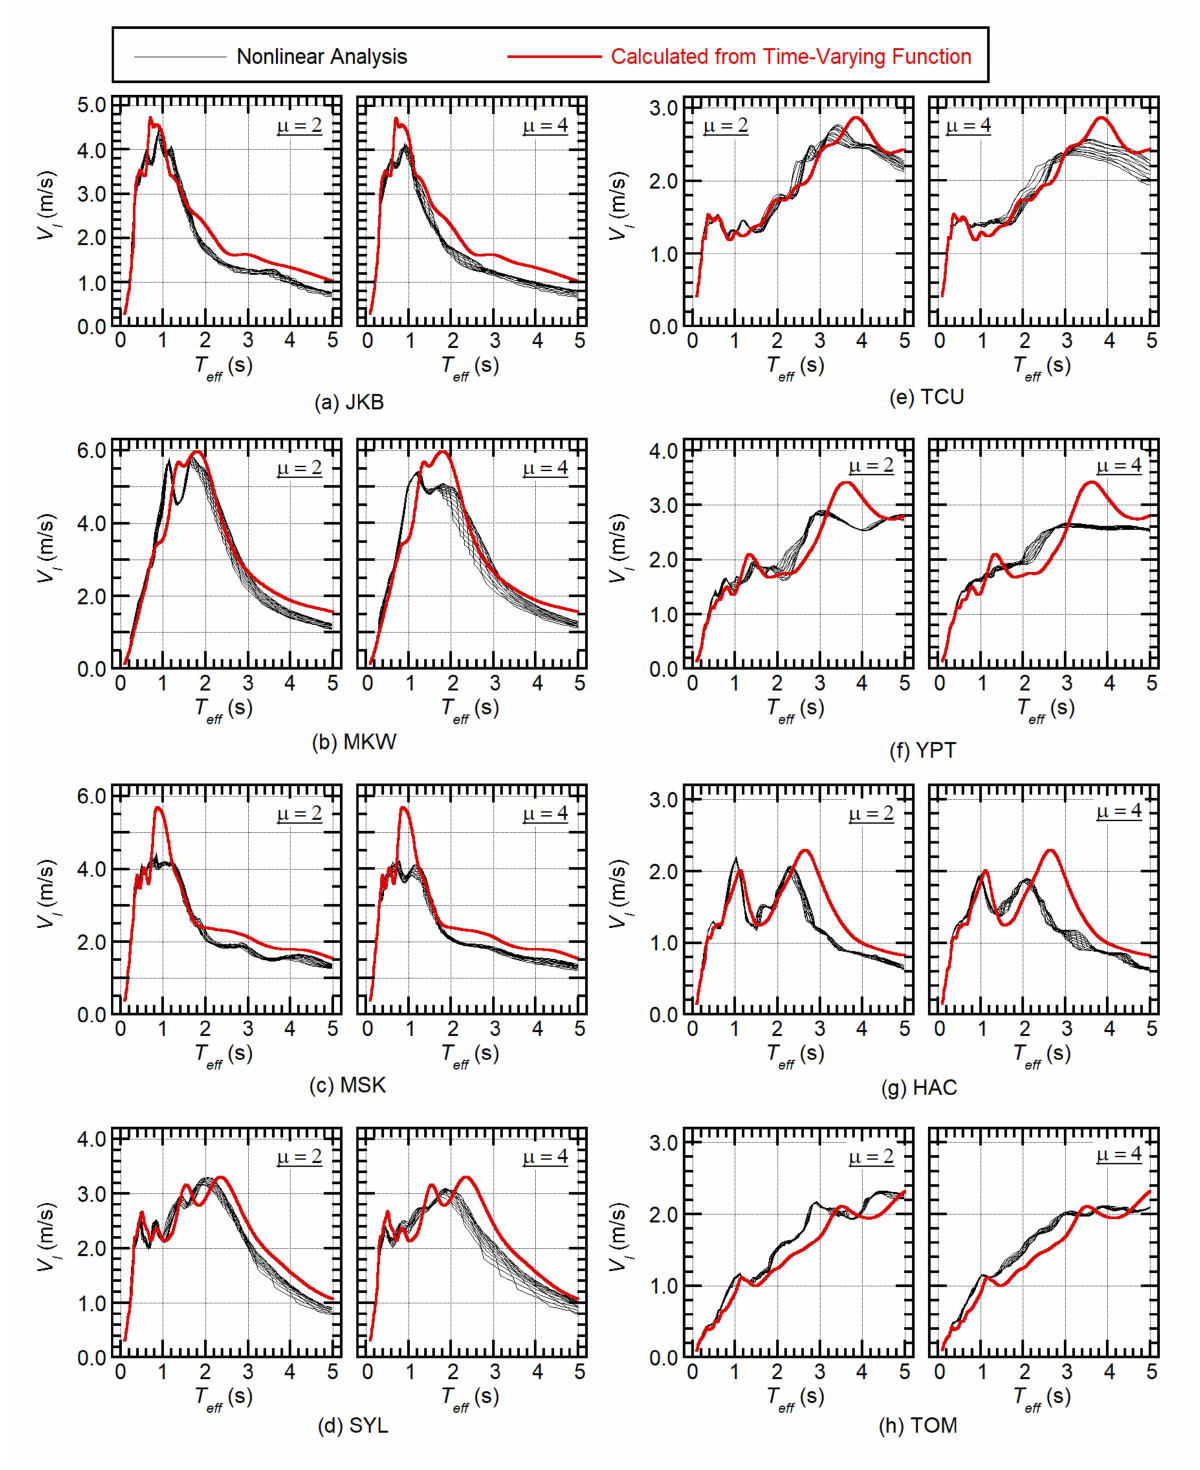
Figure 7. Evaluation of total input energy spectrum for each ground acceleration